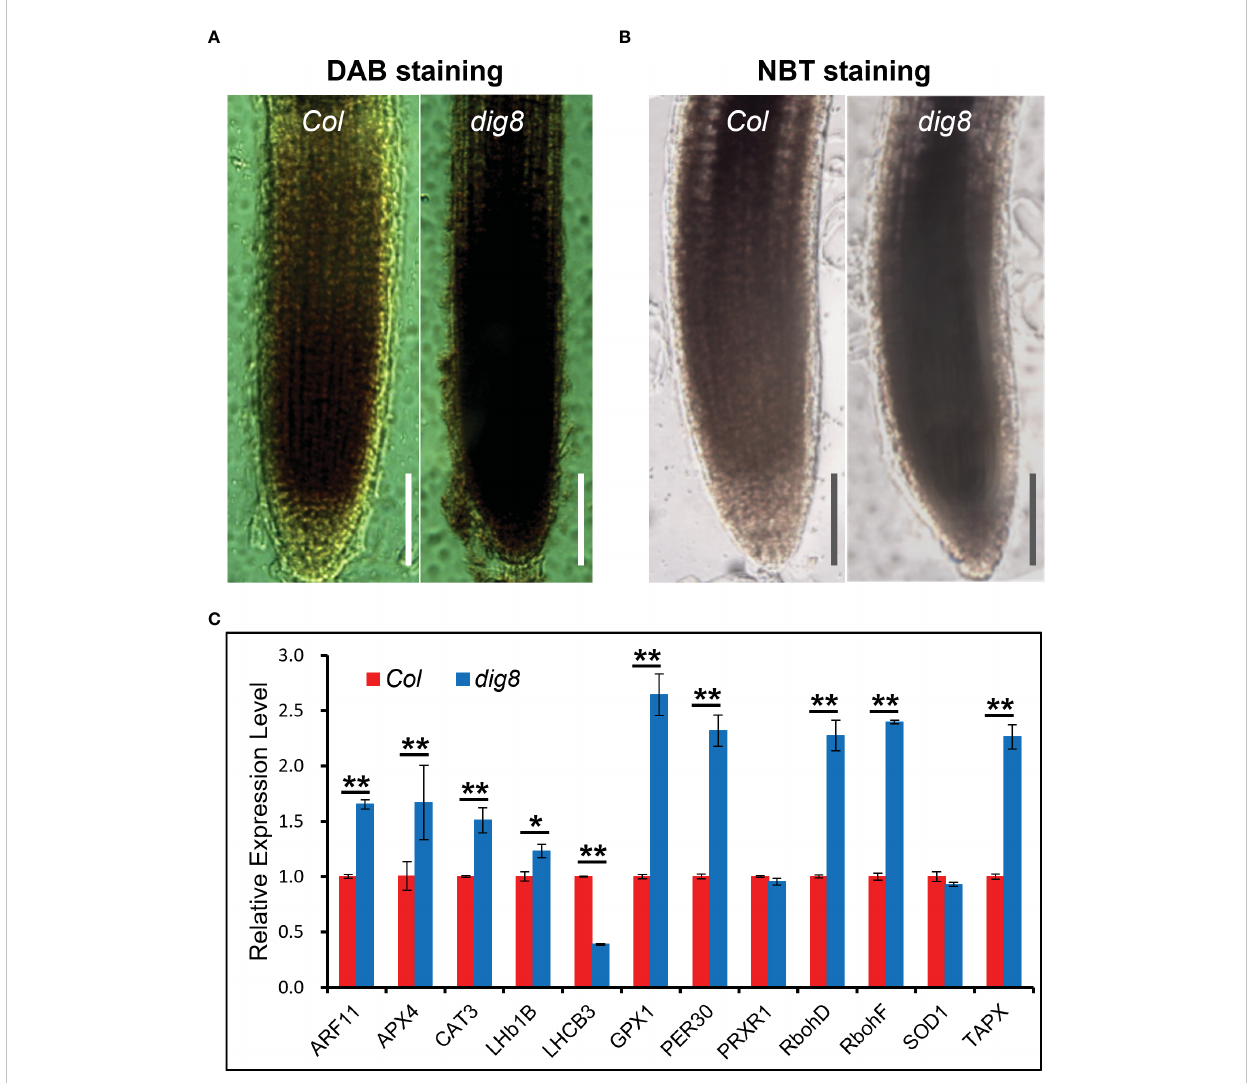
FIGURE 6 Higher ROS levels in the dig8 mutant. A and B, ROS was detected by DAB (A) and NBT (B) staining. Seedlings of Col and dig8 mutant were immersed in DAB and NBT solution at room temperature, and decolorization in ethanol. The images were captured with a Leica M80 stereo microscope. Scale Bar, 1 mm. (C) , qRT-PCR analysis of ROS-related genes in Col and dig8 mutant. Error bars represent SDs among three independent replicates. Asterisks indicate a signi fi cant difference between the indicated samples ( t -test, *P < 0.05, **P <